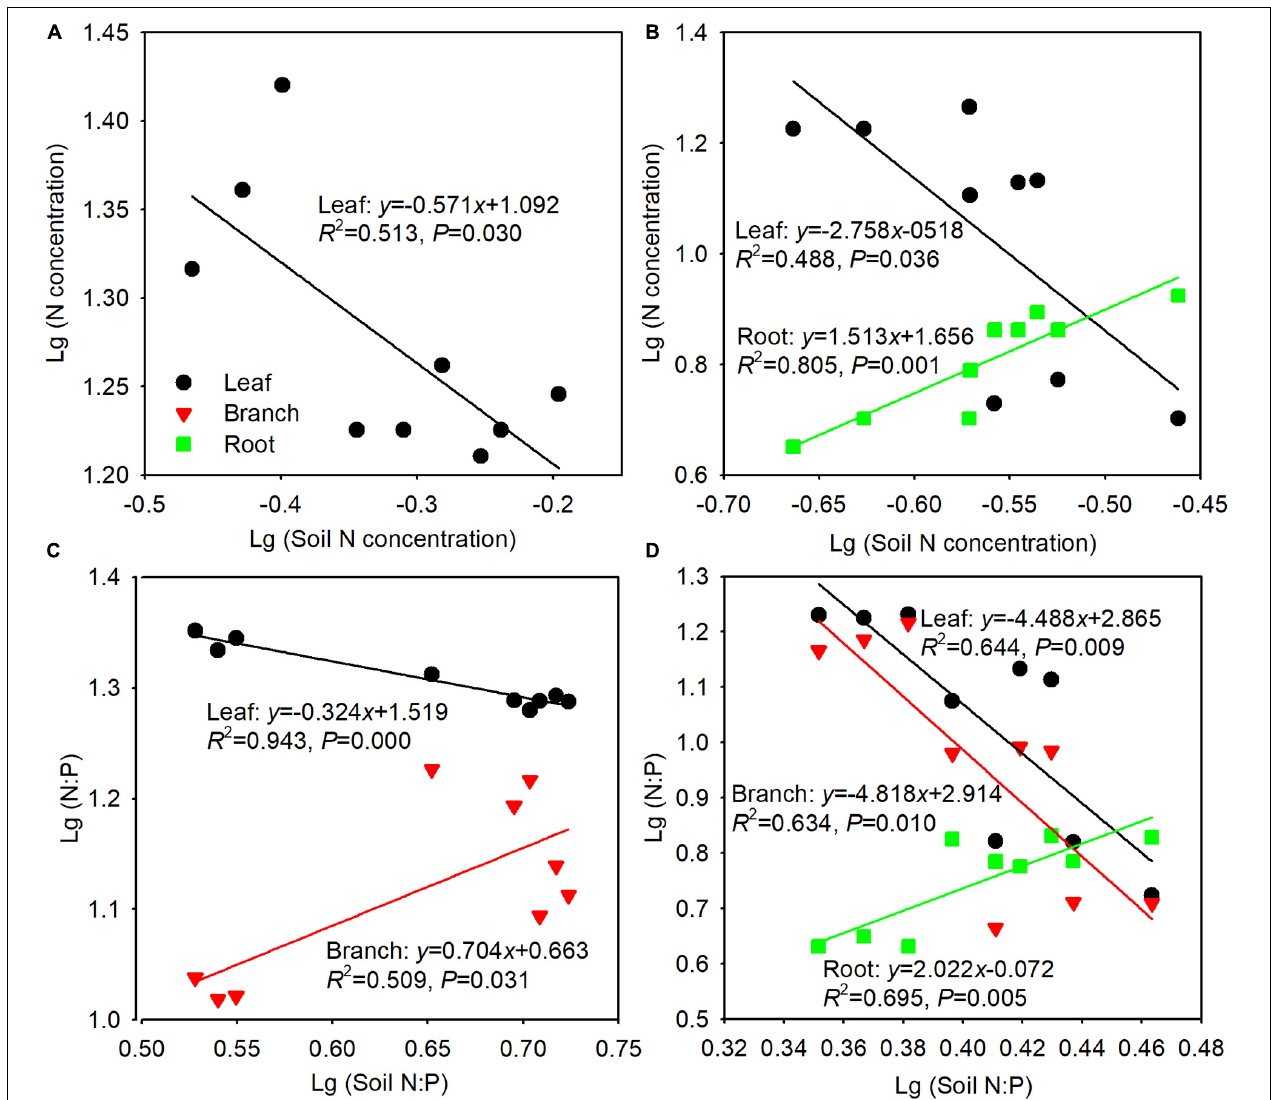
FIGURE 5 | Relationships between tree organ and soil N concentration in Siberian elm (A) and Silver poplar (B) plantations, and N:P in Siberian elm (C) and Silver poplar (D) plantations. Only the cases with significance are shown. ( n = 9 with 3 plots × 3 sampling